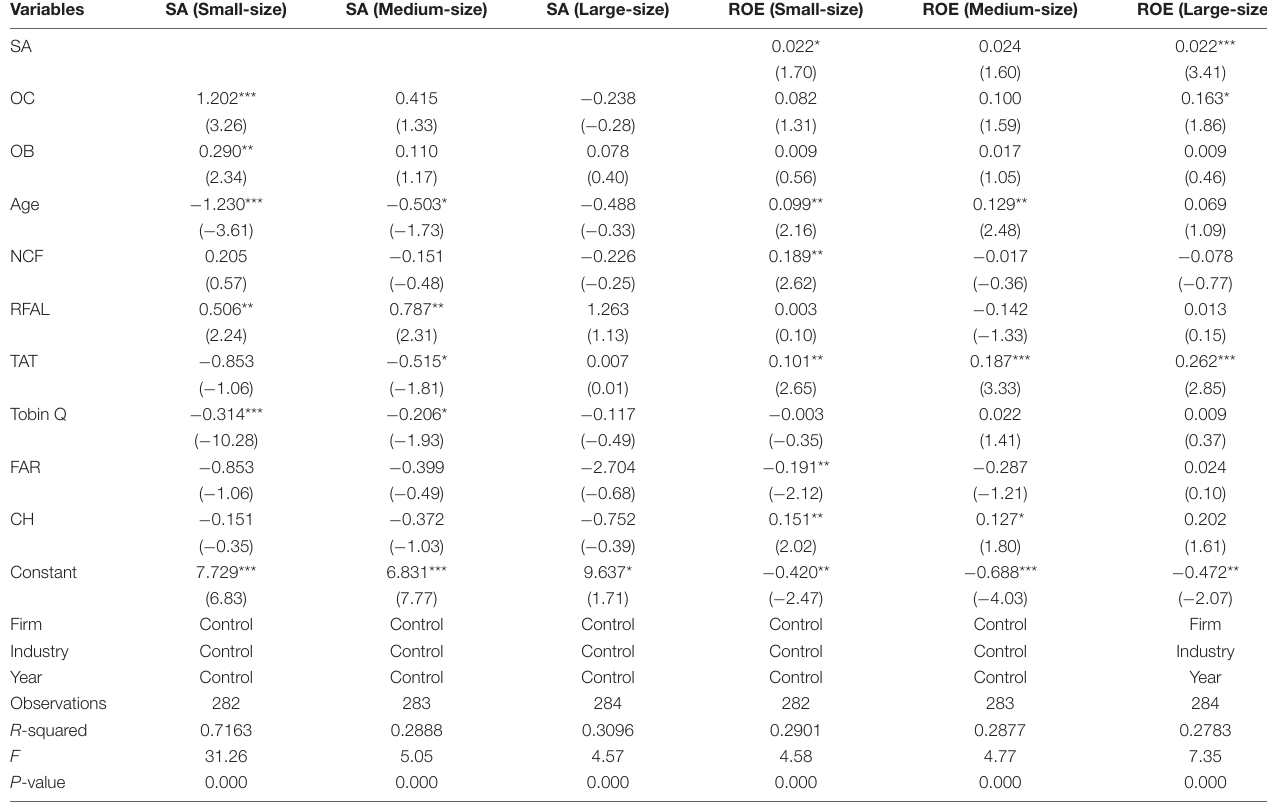
TABLE 9 | Multiple regressions based on different firm